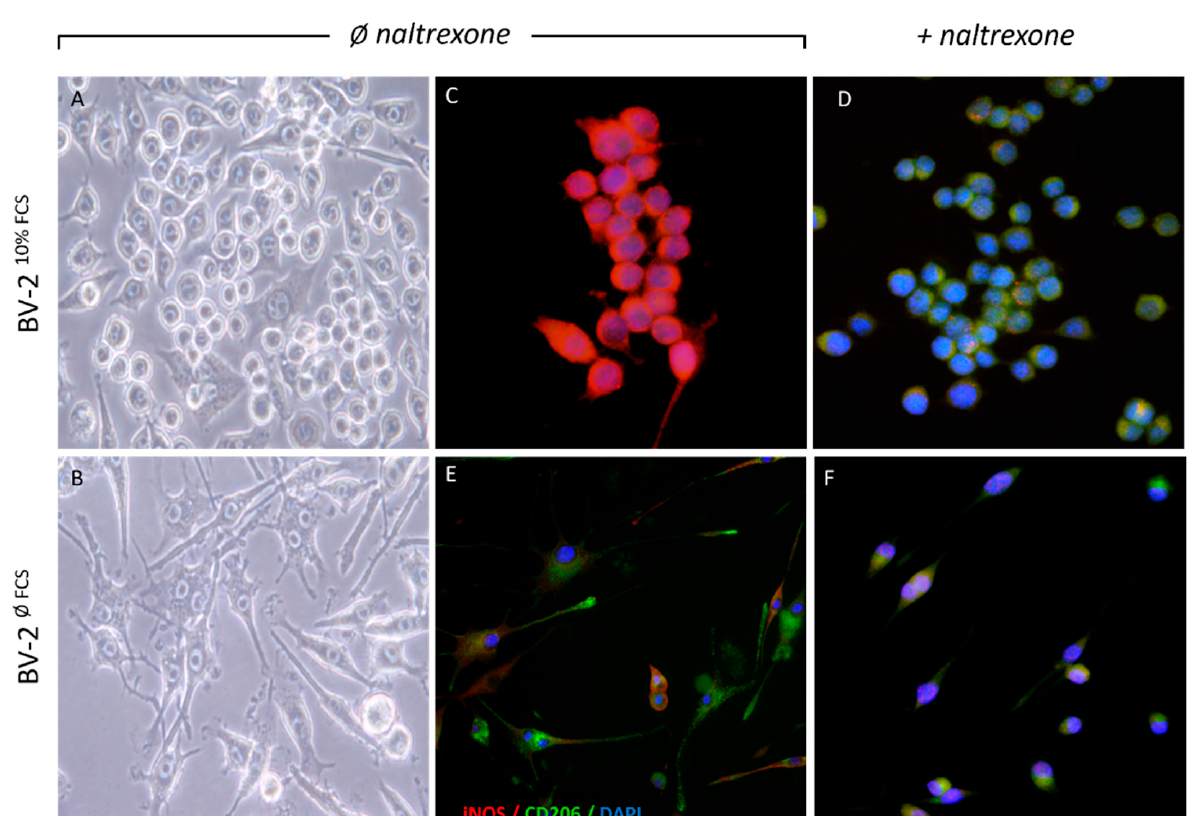
Figure 1. A distinct cell morphology and M1/M2 activated state of BV-2 microglia cells under the different culture conditions and the effect of naltrexone in the both cell phenotypes. The cells were cultivated long term in two different conditions: in the DMEM medium supplemented with 10% FCS (BV-2 10%FCS ) (upper panel) or without FCS (BV-2 øFCS ) (lower panel) for 96 h prior to experiments. Different cell morphology phenotypes (amoeboid, ( A ) and branched, ( B )) are shown and clearly visible with the bright field /phase-contrast (left panel) and immunofluorescence (IF) (right panel) images. BV-2 10%FCS cells not treated with naltrexone ( C ) exhibit increased iNOS expression, without visible CD206 expression, while the opposite is seen in cells treated with naltrexone ( D ). There are no significant changes in marker expression seen in BV-2 øFCS with or without naltrexone stimulation ( E , F ). The IF co-localization images ( C – F ) are merged using the M1 cytoplasmic marker iNOS (red fluorescence, labelled with anti-rabbit Ab conjugated with Alexa 555), the M2 cytoplasmic marker CD206 (green fluorescence, labelled with anti-rat Ab conjugated with Alexa 488) and the nucleic stain with DAPI (blue fluorescence). Image magnification was 40–60 ×.